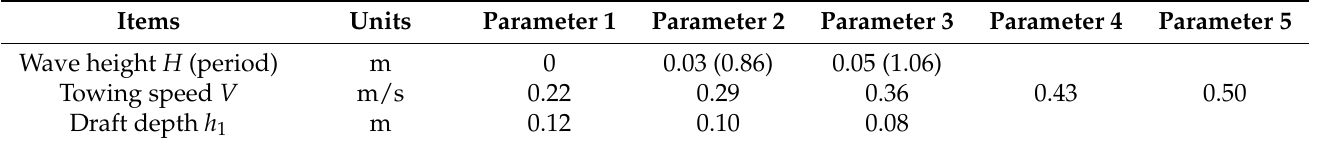
Table 3. Wet-towing conditions used in the test.